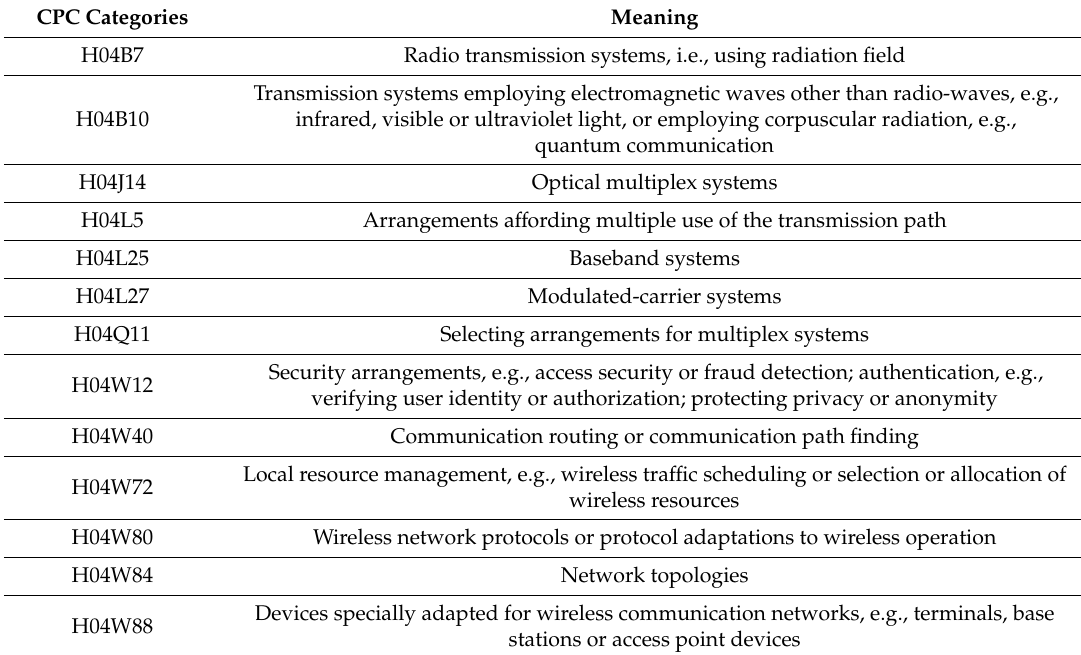
Table A1. Definitions of the level-4 CPC